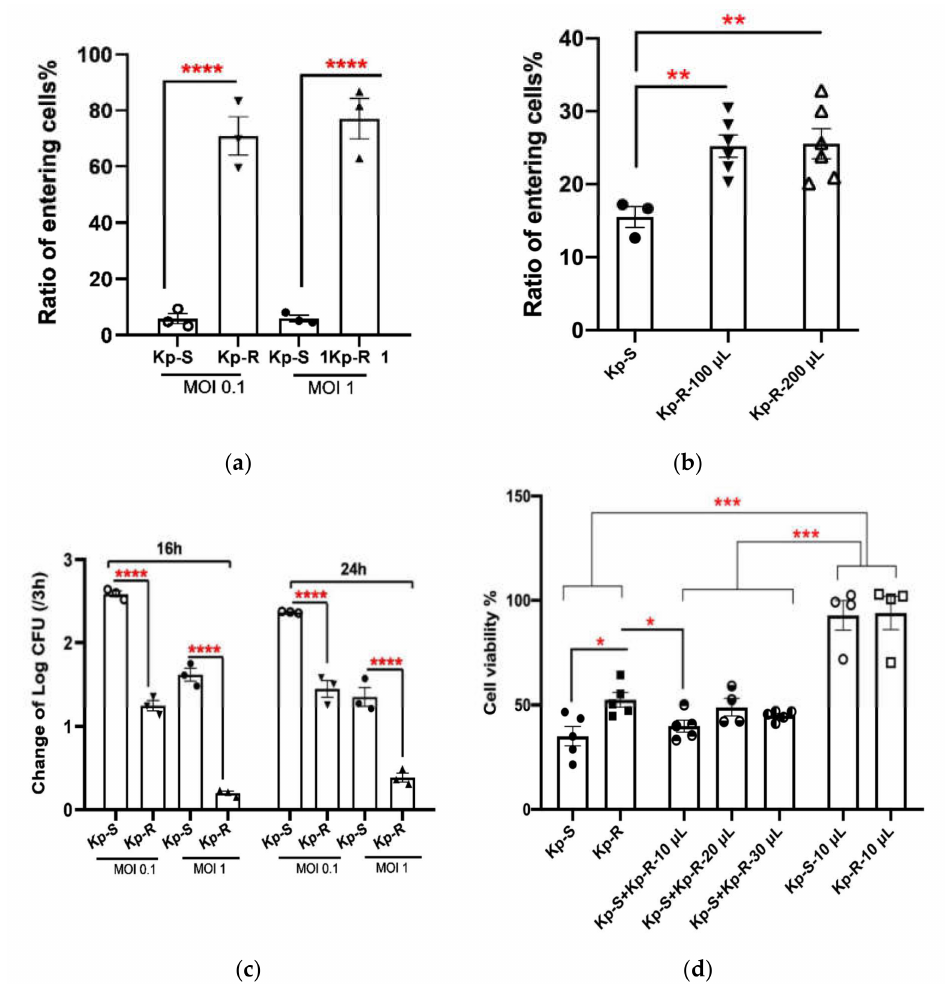
Figure 2. Adherence assay, bacterial intracellular proliferation, and cytotoxicity assay in Kp-R and Kp-S-infected A549 cells. ( a , b ) Ratio of entering bacterial cells was enumerated when Kp-R- and